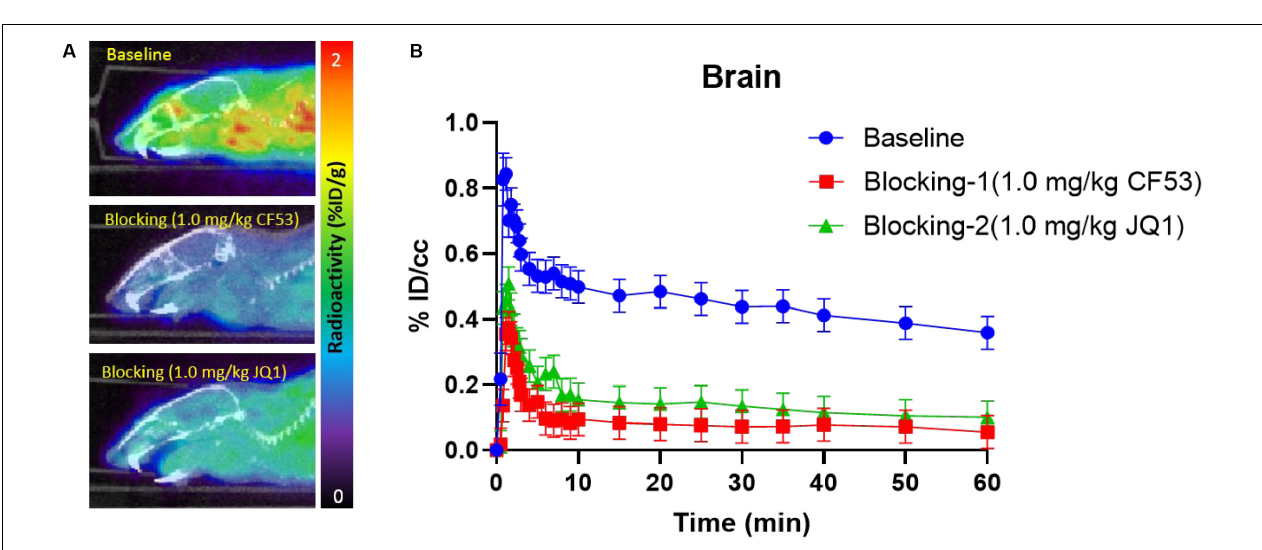
FIGURE 3 | The mice body PET/CT baseline and blocking (1.0 mg/kg CF53 and 1.0 mg/kg JQ1) imaging of [ 11 C]1 and time-activity curve of organs of interest demonstrating uptake of radioligand for baseline and blocking studies (The images are summed from 20 min to 60 min, n = 2).